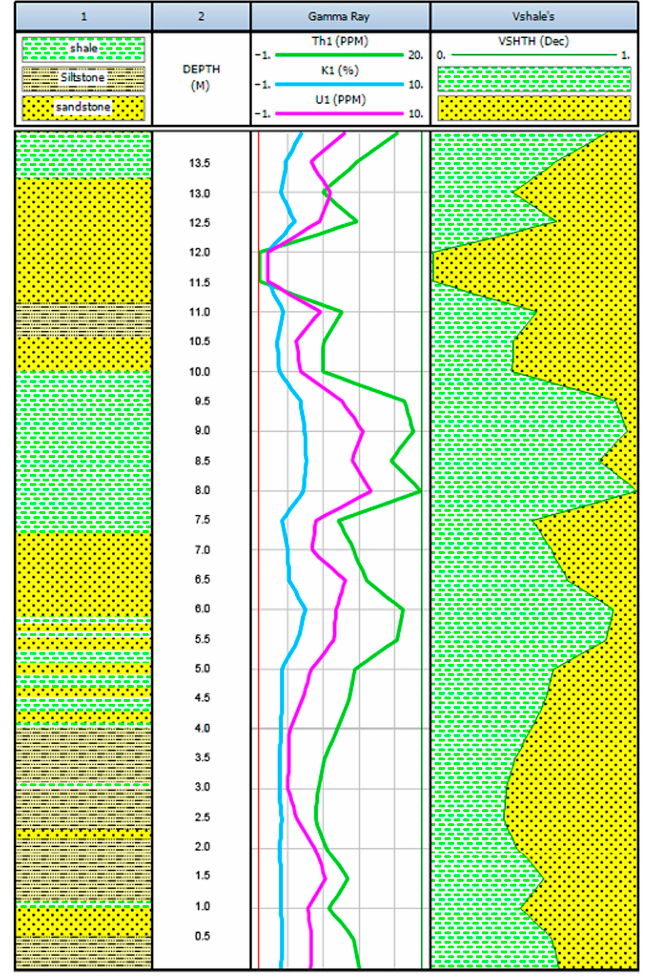
Figure 8. The sedimentary log of the L1 outcrop, including lithology thicknesses, texture, SGR values, and shale volume.